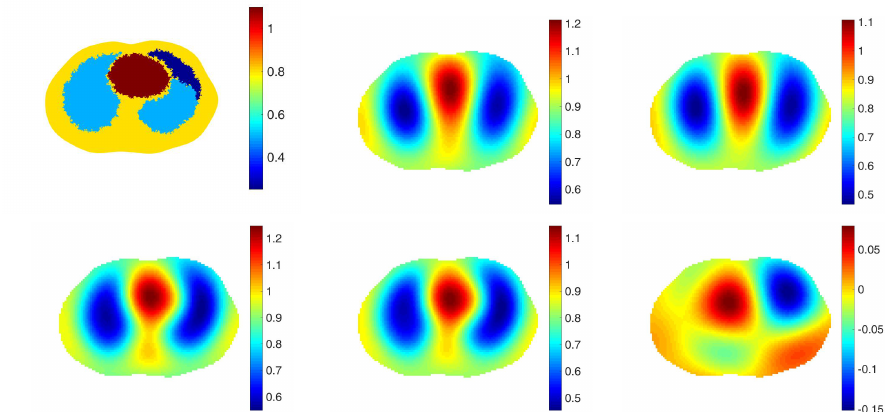
Figure 4. Large pneumothorax. From top left: The true conductivity distribution, reconstruction of γ abs with no prior, γ diff with no prior, γ abs pr with the spatial prior, γ diff pr with the spatial prior, a difference image in which the data for the example of healthy heart and lungs in Figure 2 with no pathology is chosen for γ ref . The L2 norms of the differences between those reconstructions and the ground truth are 0.3076, 0.3261, 0.3047 and 0.3232 in order.